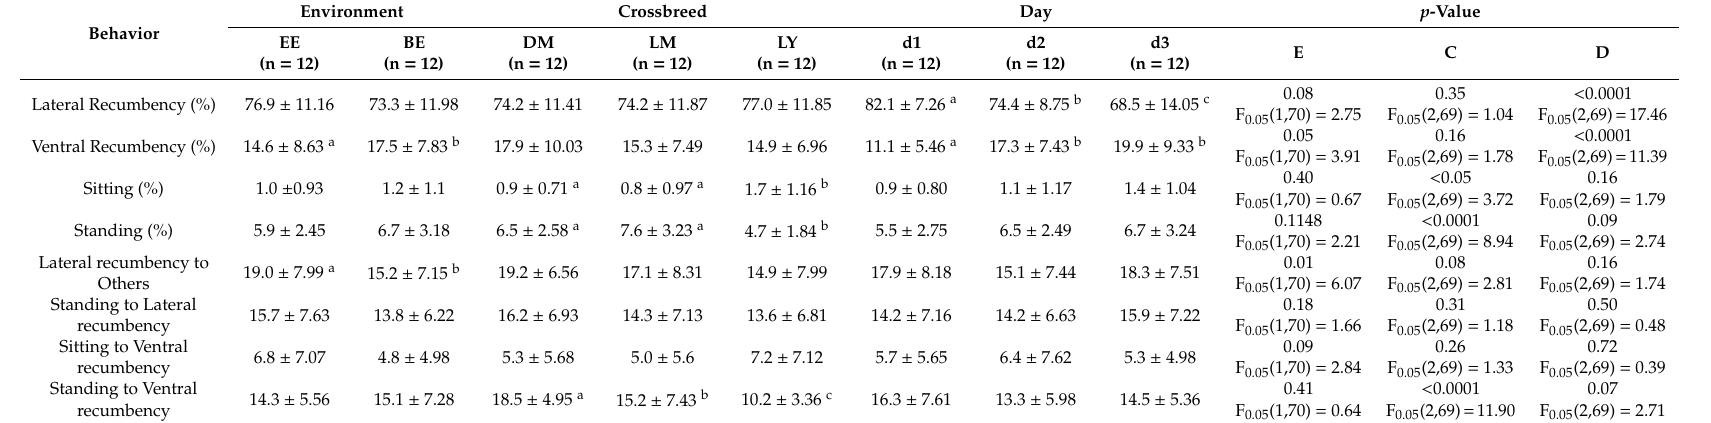
Table 3. Maternal behavior of sows during the first three days of